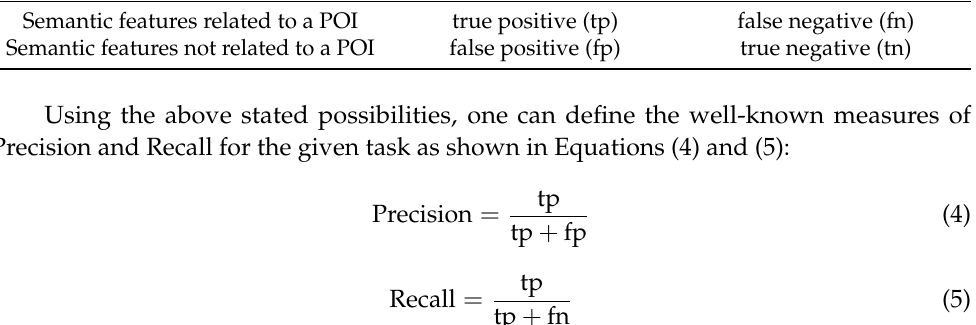
Table 4. Confusion matrix. Extracted Not Extracted Semantic features related to a POI true positive (tp) false negative (fn) Semantic features not related to a POI false positive